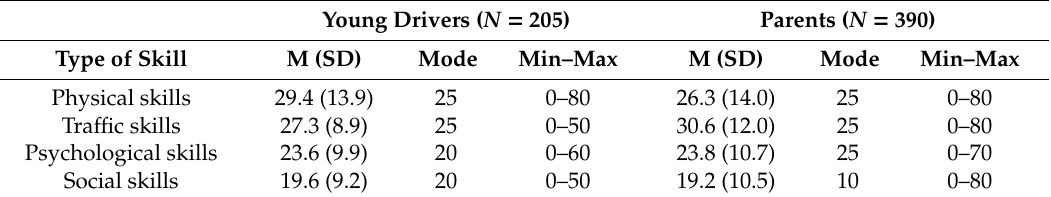
Table 1. Mean percentage amounts that young drivers and parents nominated that each skill type should be taught using a driving